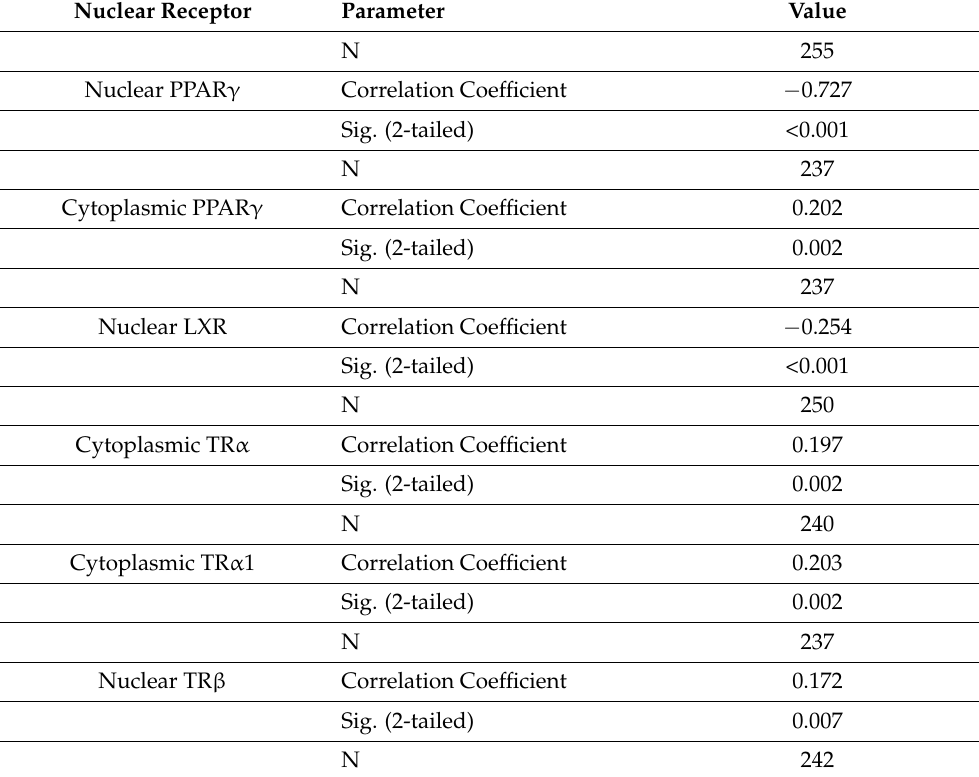
were also detected in the cytoplasm. We identified weak but significant positive correlations between TILs and cytoplasmic type II receptors (Table 3). Table 3. Correlation of nuclear and cytoplasmic staining of type II nuclear receptors with TILs assessed by the Salgado score (green or orange: weak negative or positive correlation [r] < 0.39; red: strong negative correlation [r] > 0.60).